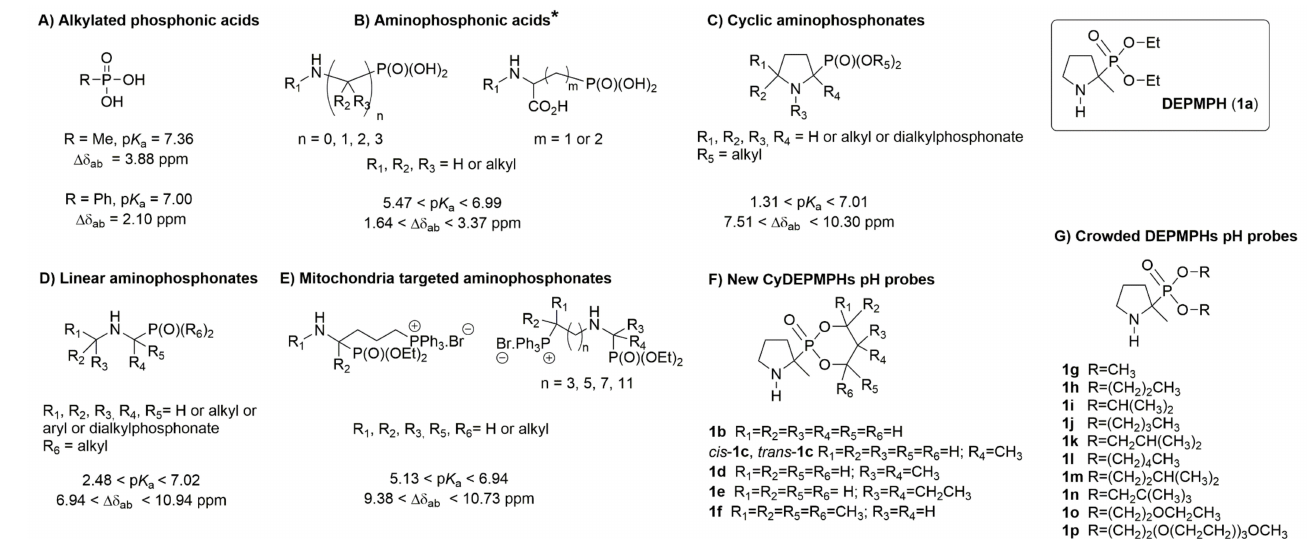
Figure 1. ( A – E ) Families of phosphorylated derivatives used as exogenous 31 P NMR pH probes. ( F ) Conformationally constrained CyDEPMPHs pH probes (current study). ( G ) Sterically crowded DEPMPH-derived pH probes (current study). Inset : Structure of DEPMPH ( 1a ). * p K a and ∆ δ ab values of the second OH of phosphonic